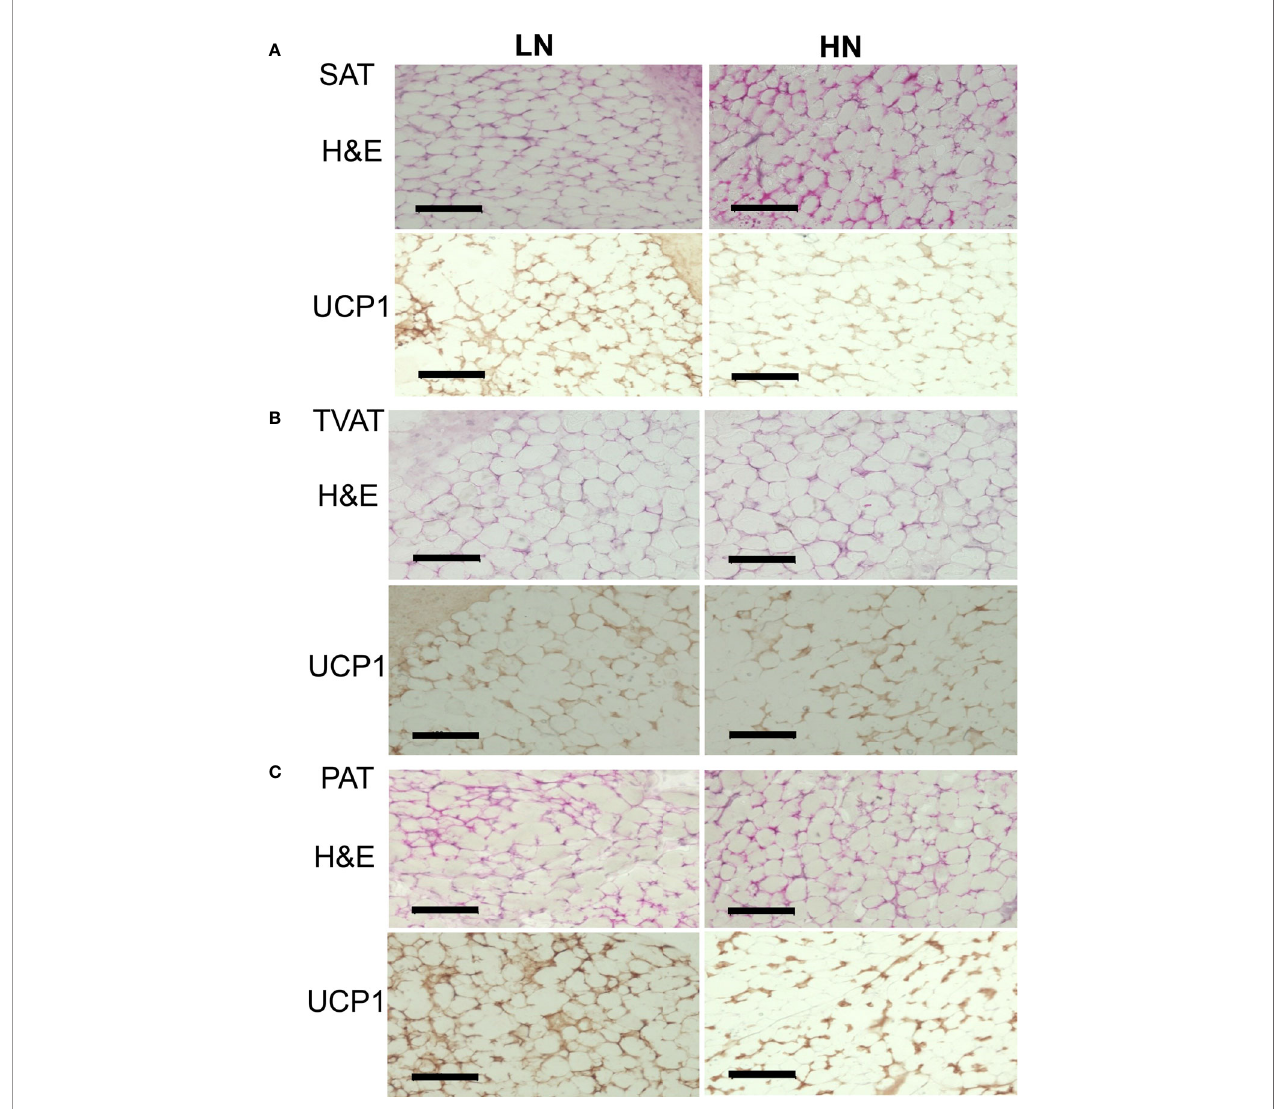
FIGURE 4 | Representative images of H&E staining and immunohistochemical staining of UCP1 in LOW and HIGH fetuses. UCP1: uncoupling protein 1. SAT: subcutaneous adipose tissue ( A , SAT). TVAT: thoracic cavity visceral adipose tissue ( B , TVAT). PAT: perirenal adipose tissue ( C , PAT) in Wagyu fetuses. Fetuses: 260 ± 8.3 days of fetal age. LOW: n=6. HIGH: n=6. Black scale bar represents 100 m m. Magni fi cation: